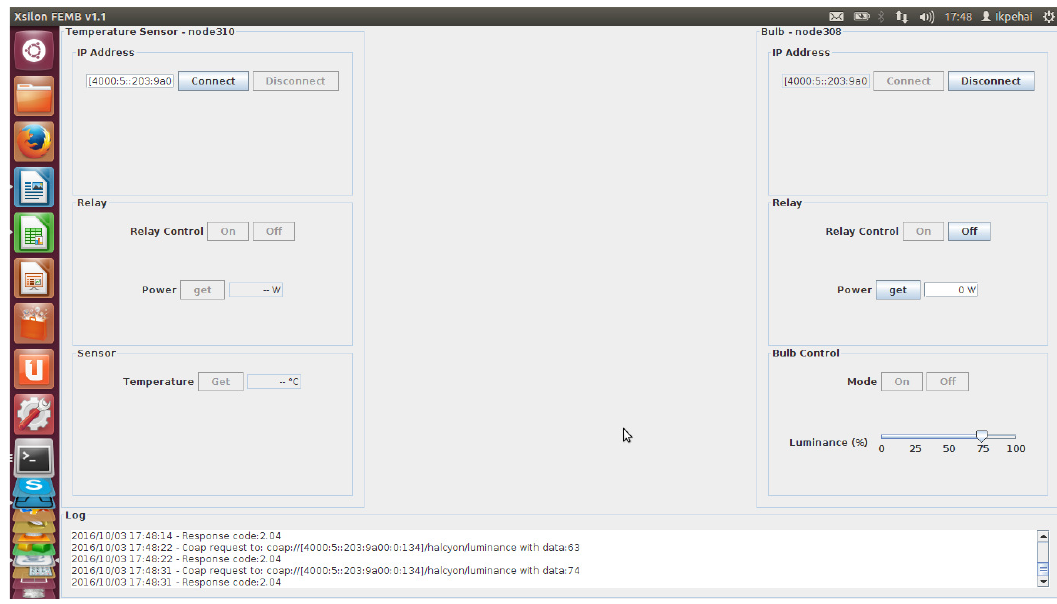
Figure 3. Constrained Application Protocol (CoAP) interface showing the monitoring (sensor) and control (lamp)